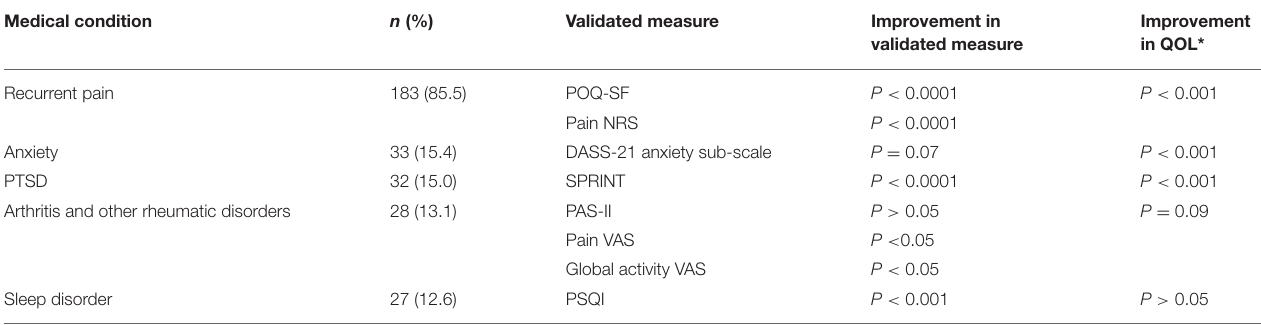
TABLE 9 | Summary of results from evaluated validated questionnaires for each of the top four medical conditions after 6 weeks of medical cannabis treatment. Medical